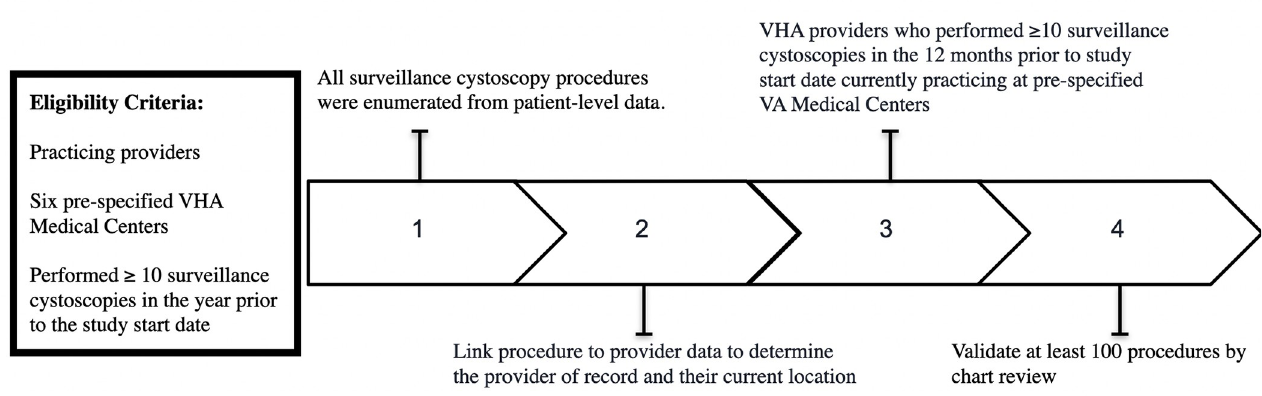
Fig 1. Flow chart showing the sequential identification process of eligible providers based on inclusion and exclusion criteria.